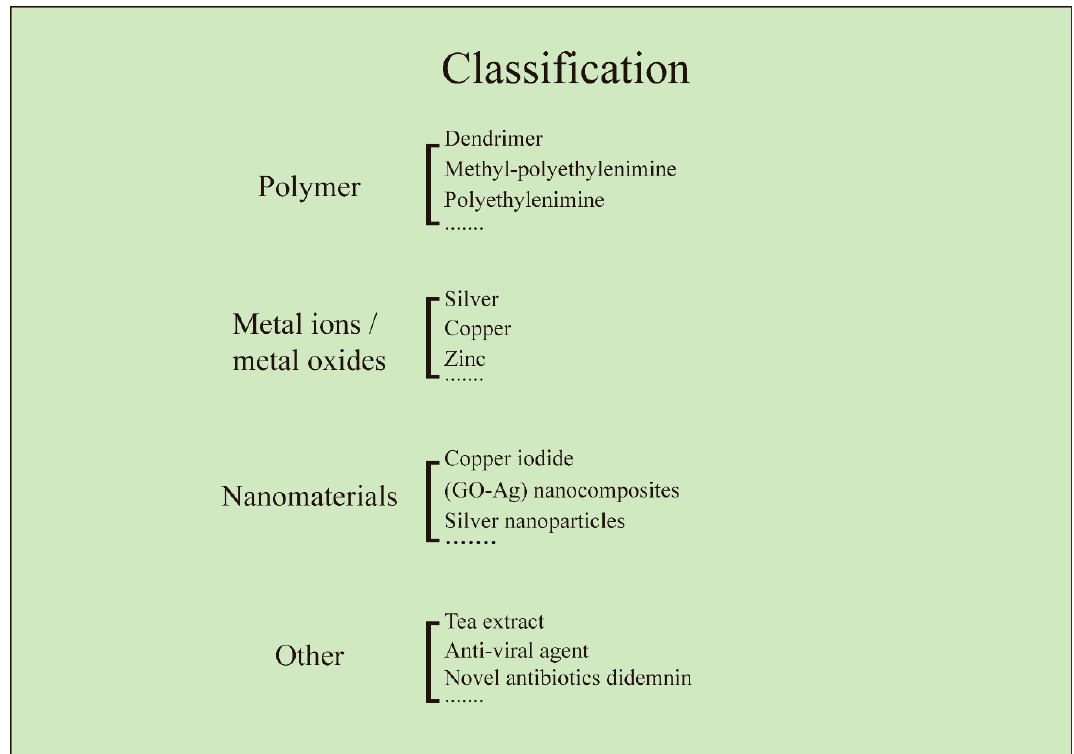
Figure 1. Classifications of various antiviral coating materials for the development of antiviral products.